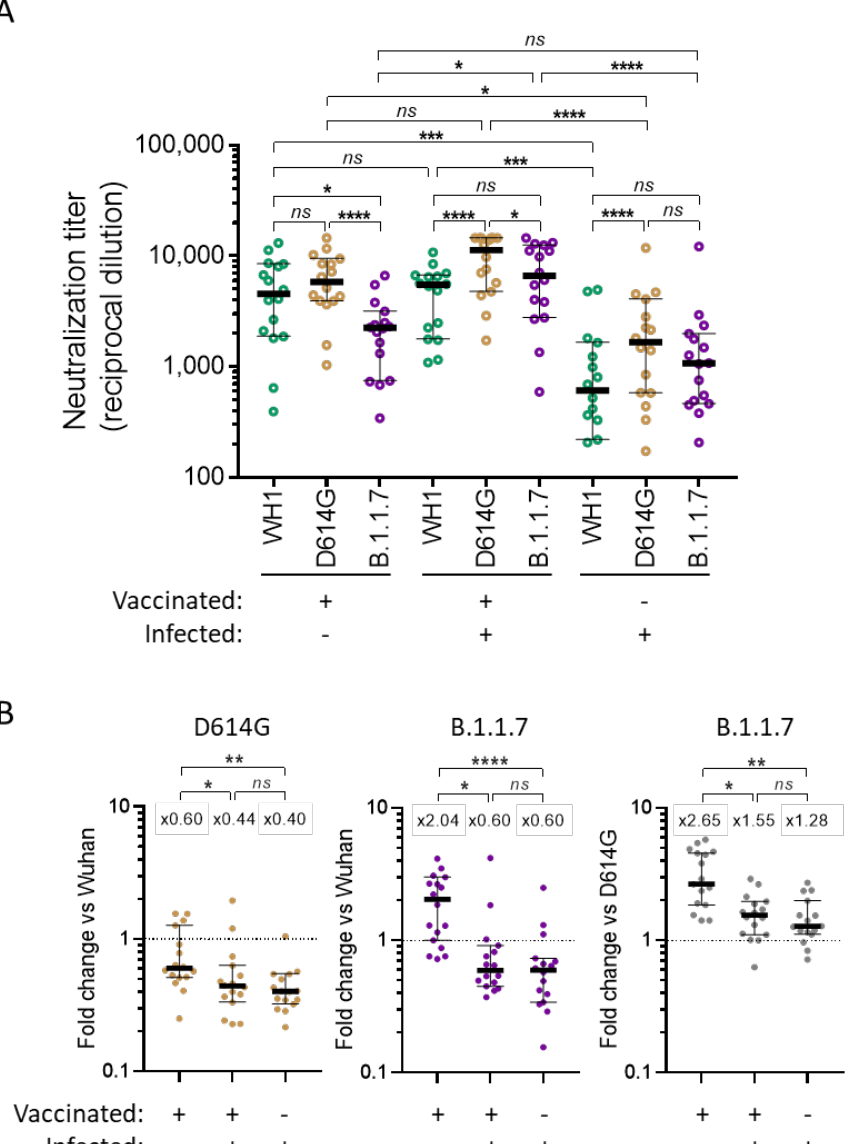
Figure 4. Subgroup analysis of neutralization titers in vaccinated individuals. Comparison of plasma from vaccinated individuals, previously infected or not during the first wave, as well as late plasma from first wave infected individuals. ( A ) Neutralization titers (ID 50 expressed as reciprocal dilutions). Bars indicate the median titer in each group with a 95% confidence interval. p values show the comparison of median titers against the three variants in the same group (Friedman with Dunn’s multiple comparison test ; * p < 0.05, **** p < 0.0001) and the comparison of the response against the same spike between groups (Kruskal–Wallis with Dunn’s multiple comparison test * p < 0.05, *** p < 0.001, **** p < 0.0001) ( B ) Corresponding ratios between variants (lower is better). Bars indicate the median in each group with a 95% confidence interval and top values indicate the median fold-change between the indicated variants (variants compared are indicated in the graph title and in the Y axis). p values show the comparison of median ratios between each group (Kruskal–Wallis with Dunn’s multiple comparison tests; * p < 0.05, ** p < 0.01, **** p < 0.0001).